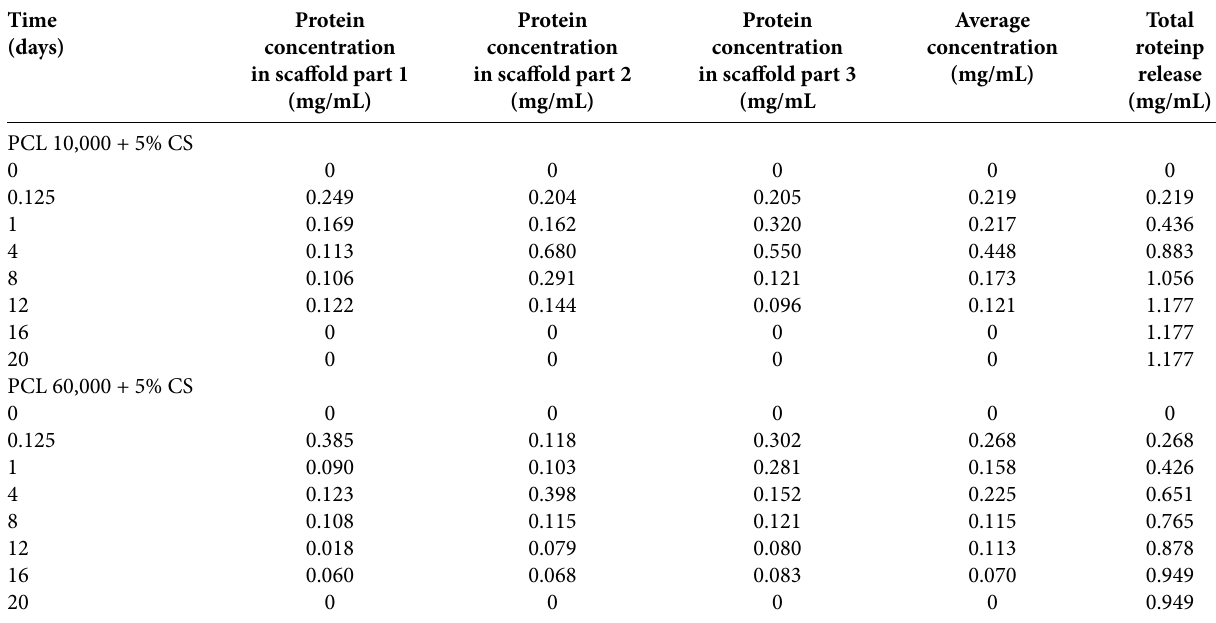
Table 3 . Concentrations of protein, released from three equal parts of scaffolds (PCL 10,000 + 5% CS and PCL 60,000 + 5% CS). Time Protein